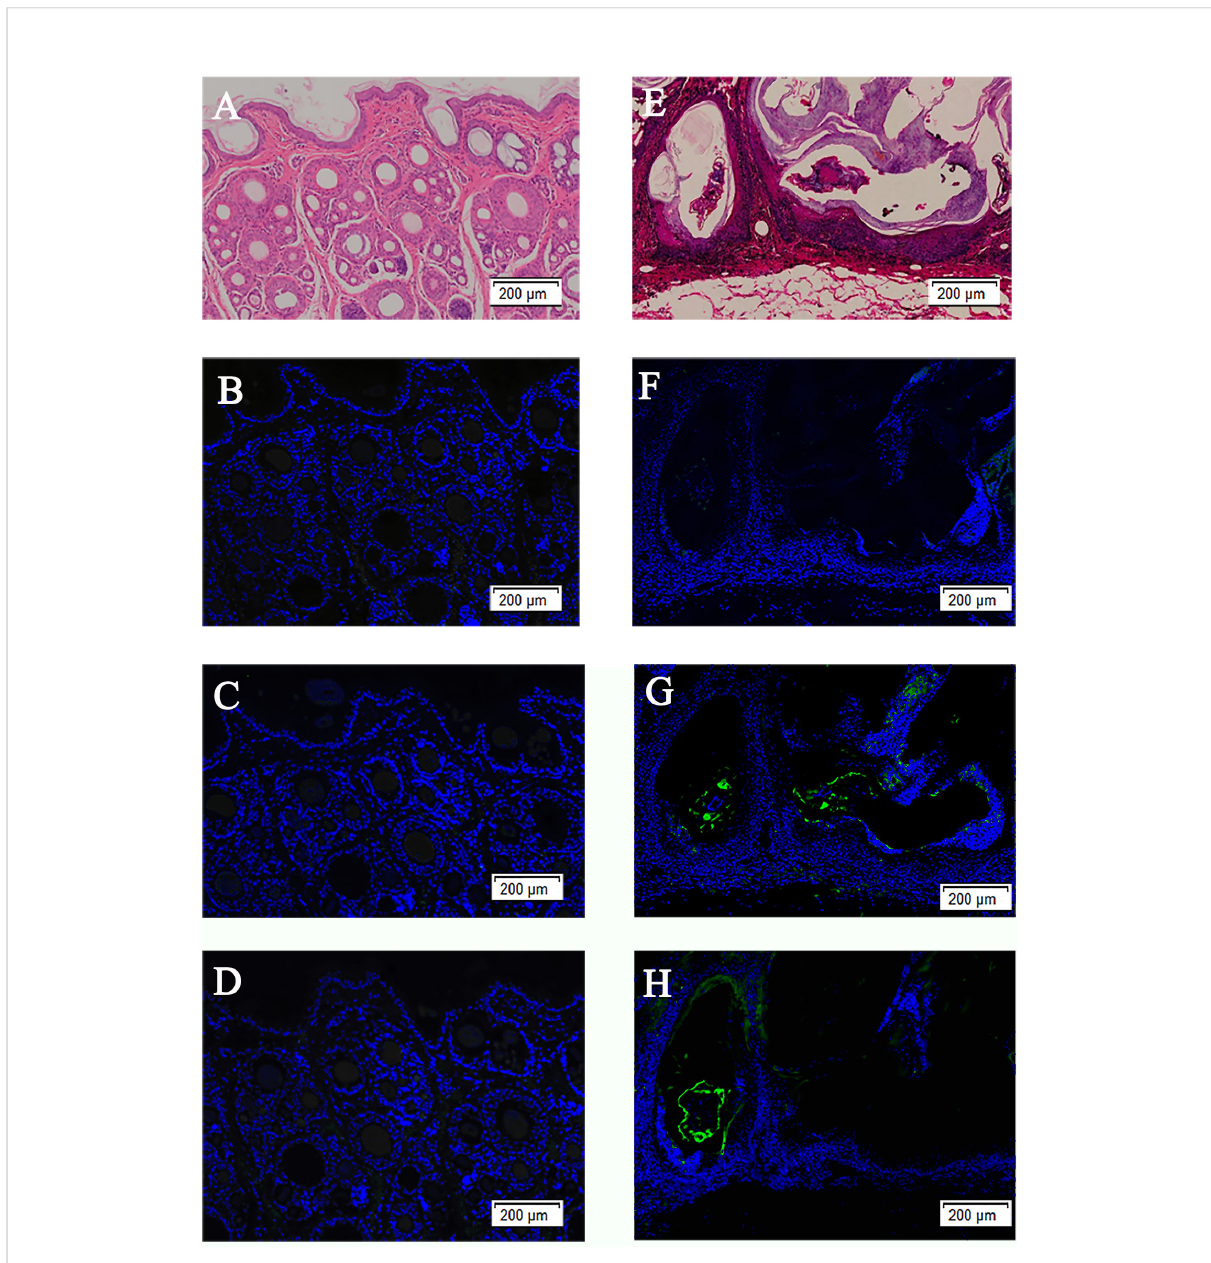
FIGURE 5 H&E staining of skin and immunolocalization of the SsAKs in the skin. H&E staining of non-skin lesions (A) and skin lesions (E) on the toes of rabbits with S. scabiei infection. The non-skin lesions (B) and skin lesions (F) on the toes of rabbits with S. scabiei incubated with rat negative serum. The non-lesion area (C) and skin lesion area (G) of the toes of rabbits with S. scabiei infection incubated with rat anti-rSsAK-1 IgG. The non-lesion area (D) and skin lesion area (H) of the toes of rabbits with S. scabiei infection incubated with rat anti-rSsAK-2 IgG. Green fl uorescence: SsAK